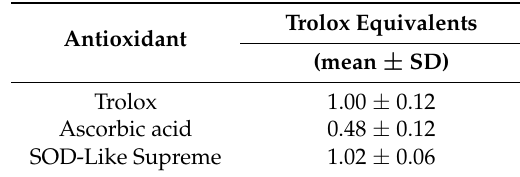
Table 2. Oxygen radical scavenging activity of SOD-Like Supreme in